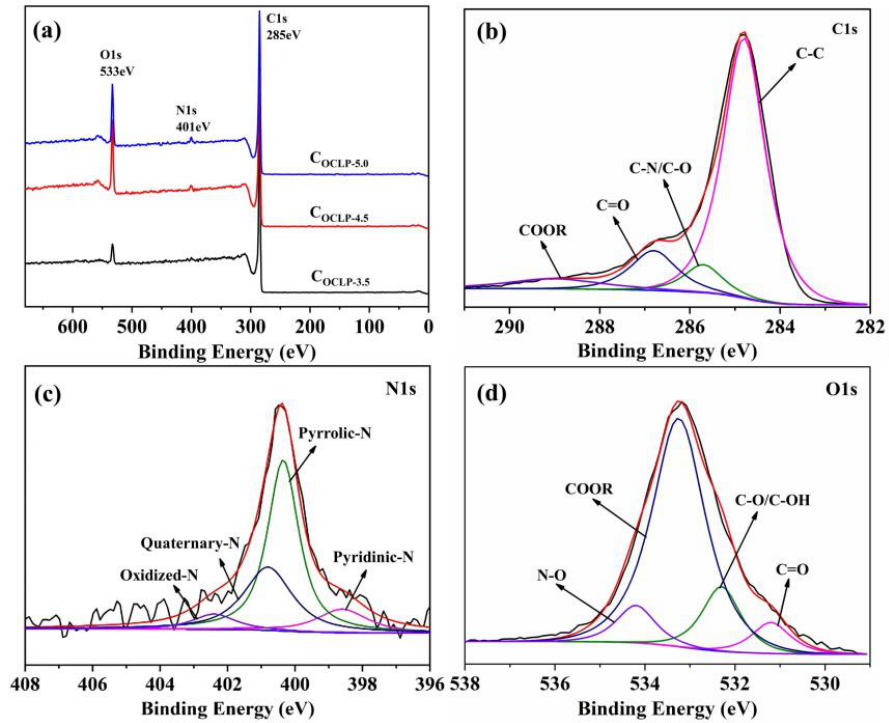
Figure 7. ( a ) XPS spectra of the C OCLPs ; ( b – d ) high resolution of C 1s, N 1s and O 1s of C OCLP-4.5 Table 2. Surface element content of the C OCLPs .